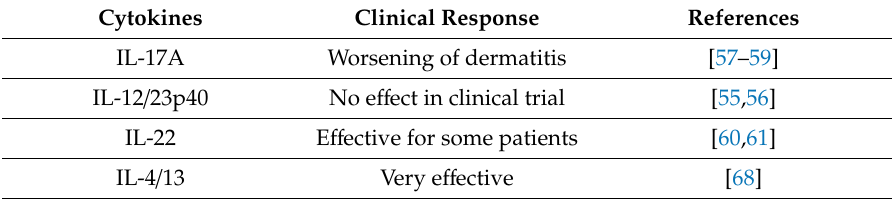
Table 1. Antibodies against Th17 and Th2-related cytokines for atopic dermatitis (AD). Cytokines Clinical Response